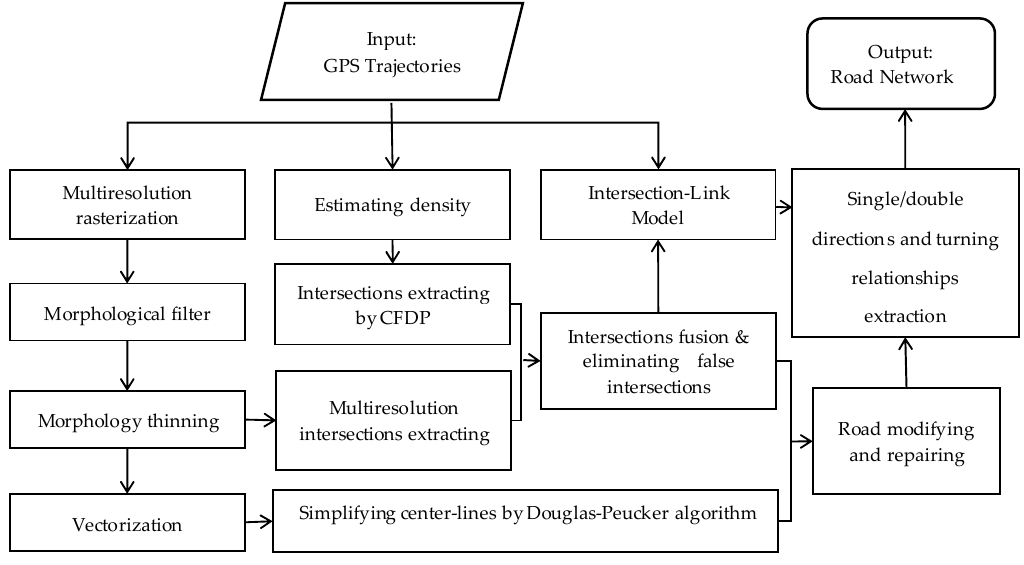
Figure 2. Workflow for road information extracting.